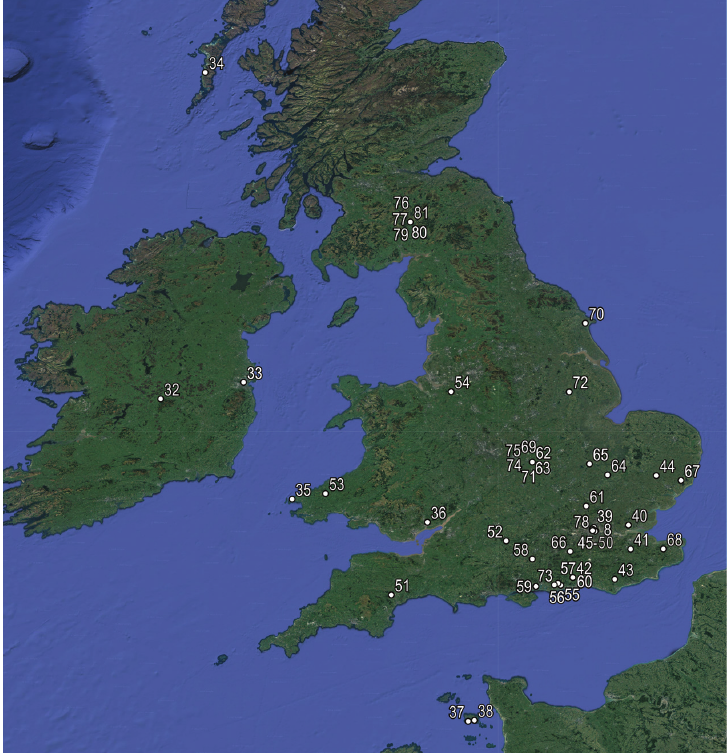
Figure 4 Map of Britain and